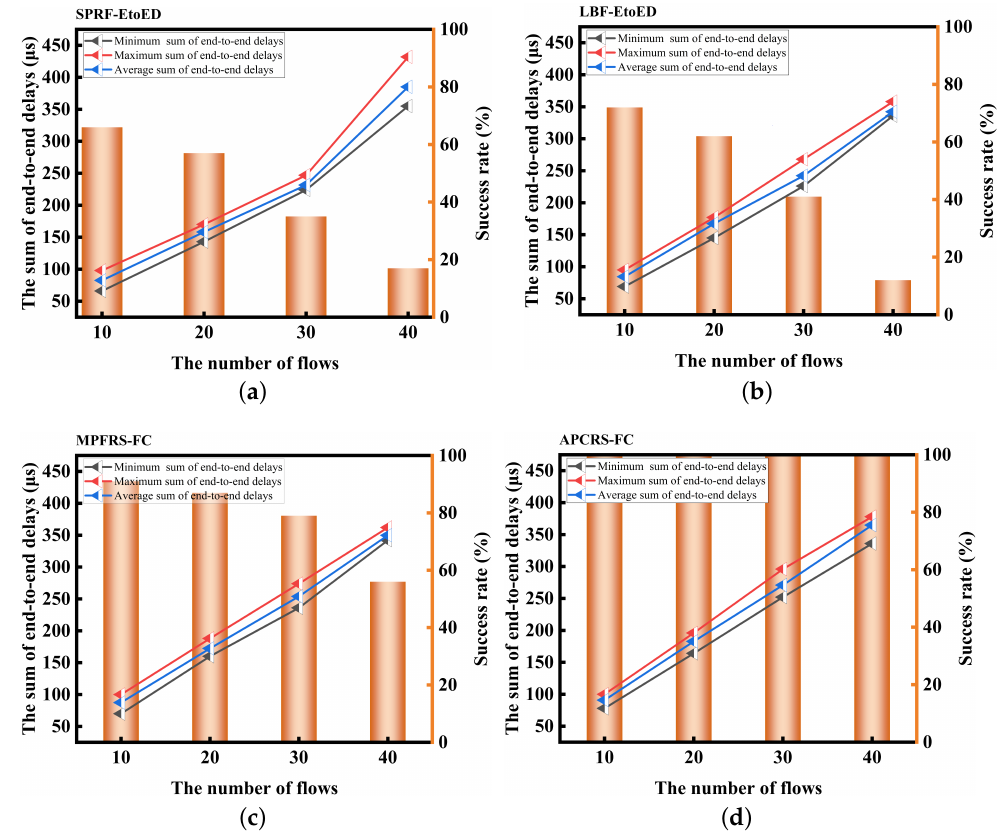
Figure 9. Success rate and the sum of end-to-end delays of the SPRF-EtoED, LBF-EtoED, MPFRS-FC, and APCRS-FC for 100 synthetic test cases with different number of flows chosen from flow group 2, tested in SM network. ( a ) Technique 1: SPRF-EtoED. ( b ) Technique 2: LBF-EtoED. ( c ) Technique 3: MPFRS-FC. ( d ) Technique 4: